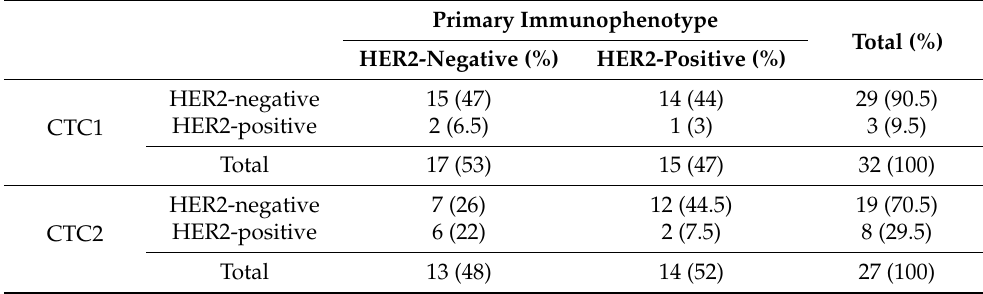
Table 2. Comparison of HER2 expression in the CTC1 and CTC2 and corresponding primary tumors.